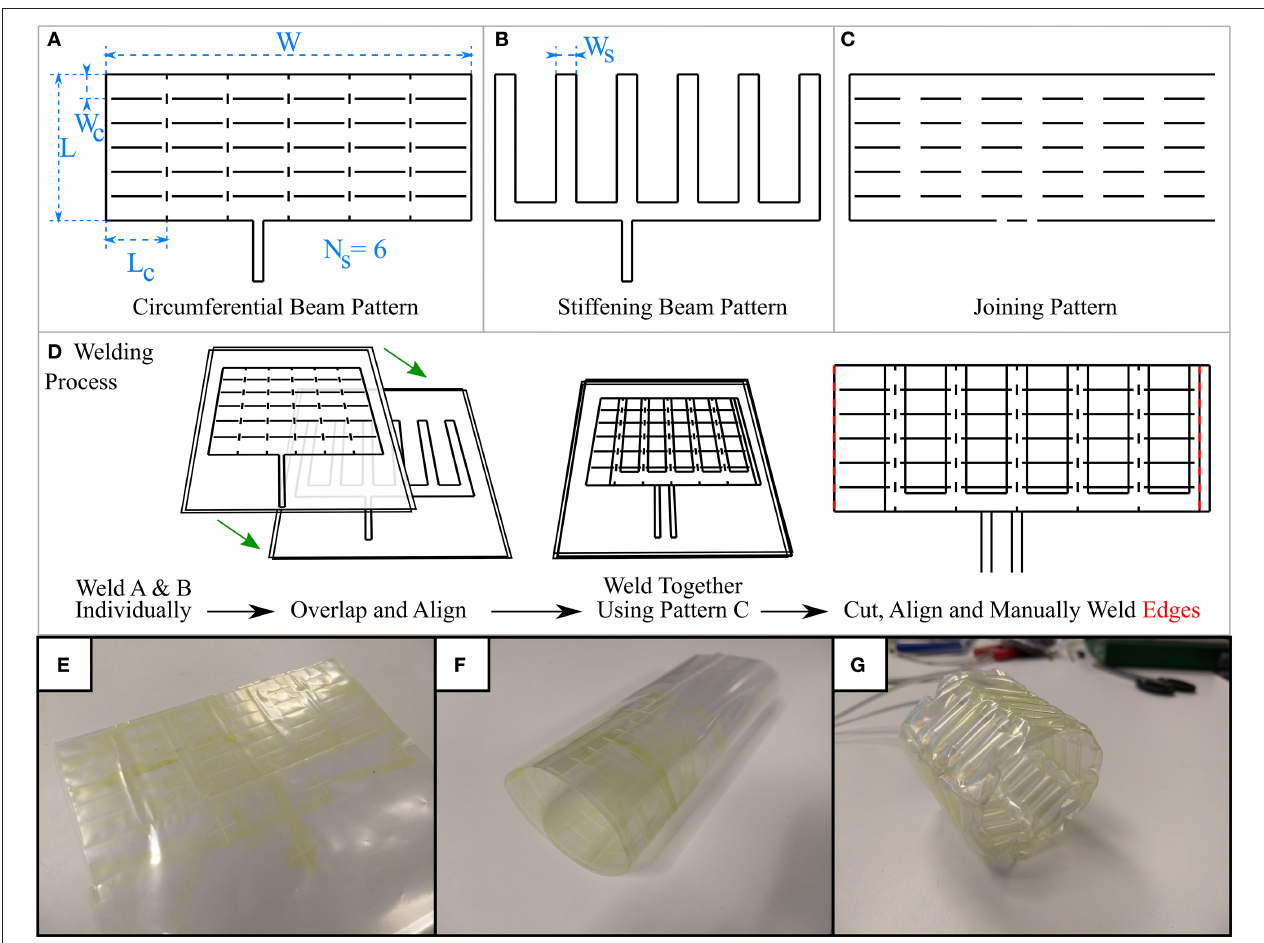
FIGURE 2 | The three weld designs generated using programmatic approach (A) the weld pattern to produce a circumferential beam layer, with key dimensions highlighted (B) weld pattern to produce stiffening beams at the prism vertices, stiffening beam width highlighted (C) weld pattern to join layers produced in A and B where their weld patterns intersect (D) process of welding layers together, followed by (E) cutting and (F) manually welding along the red lines in (D) results in a cylindrical shape (G) Lastly, the completed inflatable structure can be pressurized, taking its prismatic